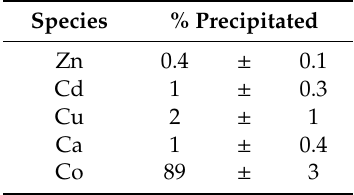
Table 8. Metal precipitation during the cobalt precipitation stage (Average ± standard deviation) for